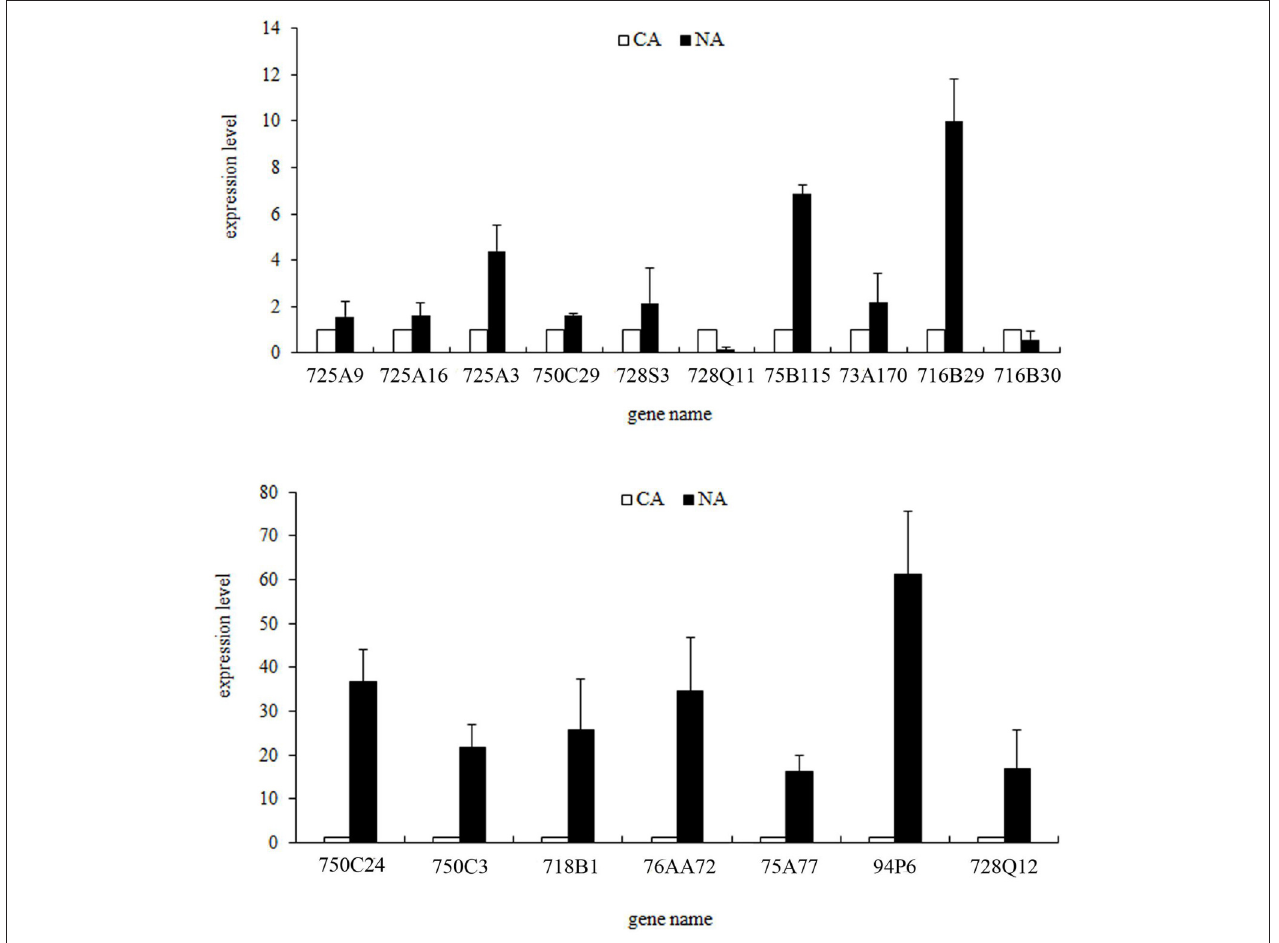
FIGURE 6 | qRT-PCR confirmation of the expression profiles of some randomly selected CYP450 genes. Fold changes of transcript levels in CA and NA are shown. Error bars indicate the mean (SEM).